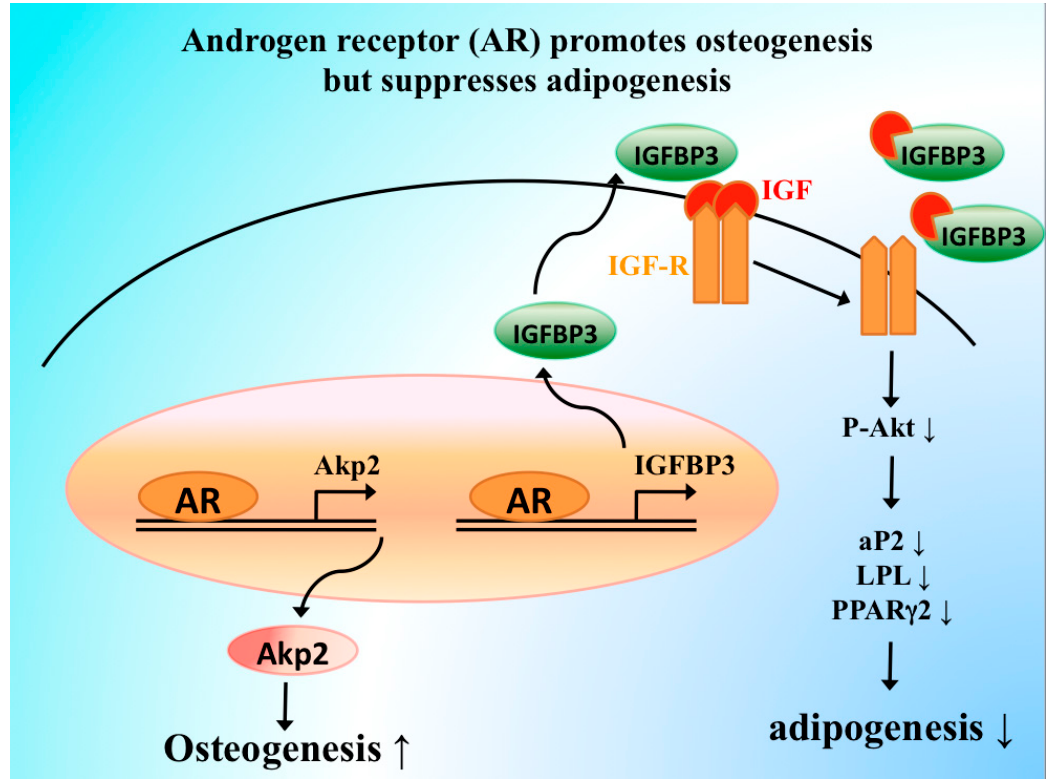
Figure 2. Androgen receptor suppresses adipogenesis but promotes osteogenesis in bone marrow stromal cells. AR increases insulin-like growth factor binding protein 3 (IGFBP3) through direct binding to its promoter region. The IGFBP3 increased by AR then participates in blocking insulin growth factor (IGF) receptor signaling to inhibit AK straining transforming (Akt) activation that leads to a decrease in the expressions of adipogenic markers, such as peroxisome proliferator-activated receptor-gamma 2 (PPAR γ 2), lipoprotein lipase (LPL), and adipocyte protein 2 (aP2), and causes less adipocyte differentiation. On the other hand, AR induces the expression of alkaline phosphatase 2 ( Akp2 ) to promote osteogenesis.